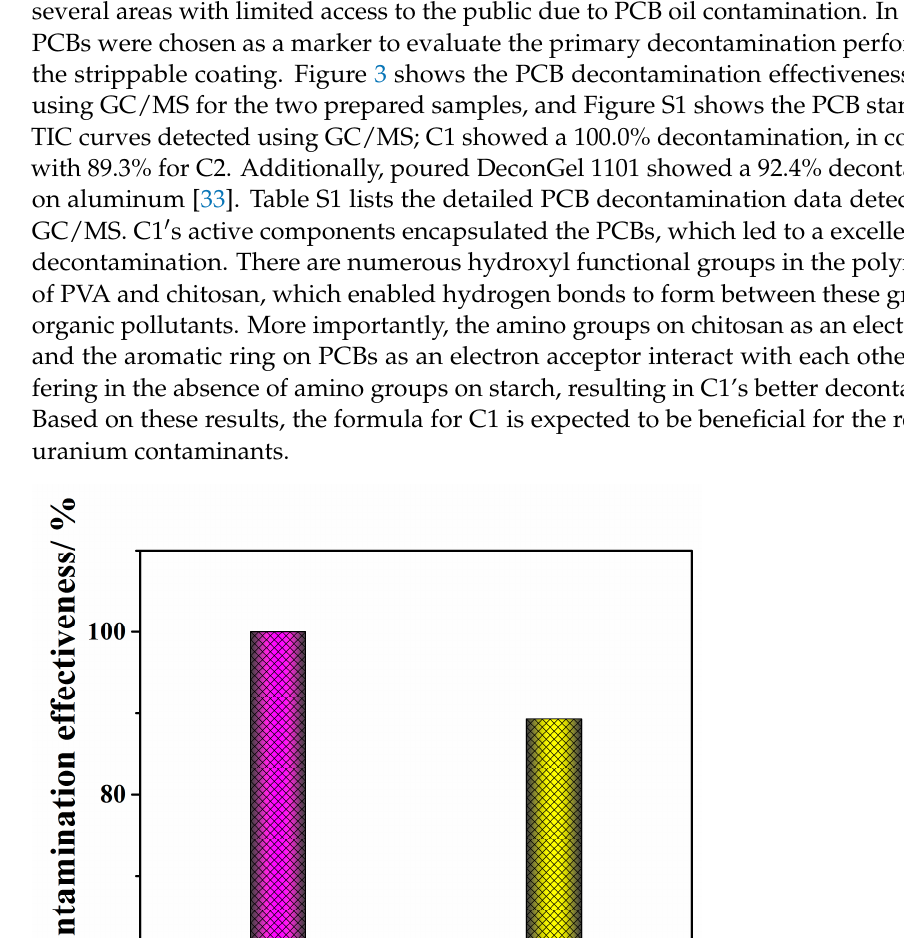
Figure 2. Micro morphology of dried polymeric film ( a ) C1 and ( b ) DeconGel 1101.